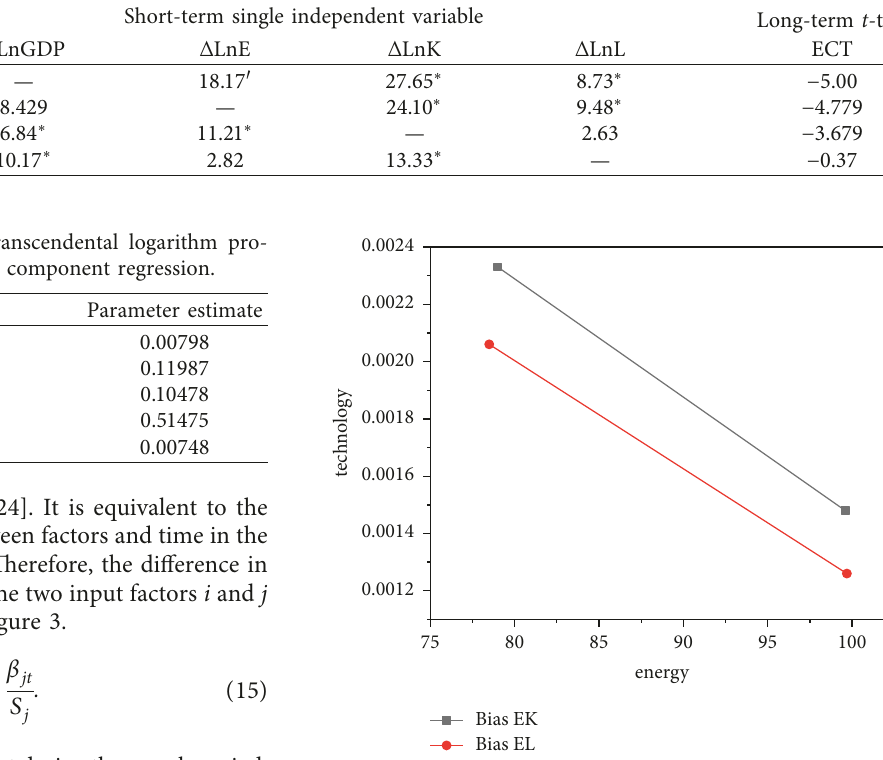
Figure 3: Differences in the technological progress of input factors.